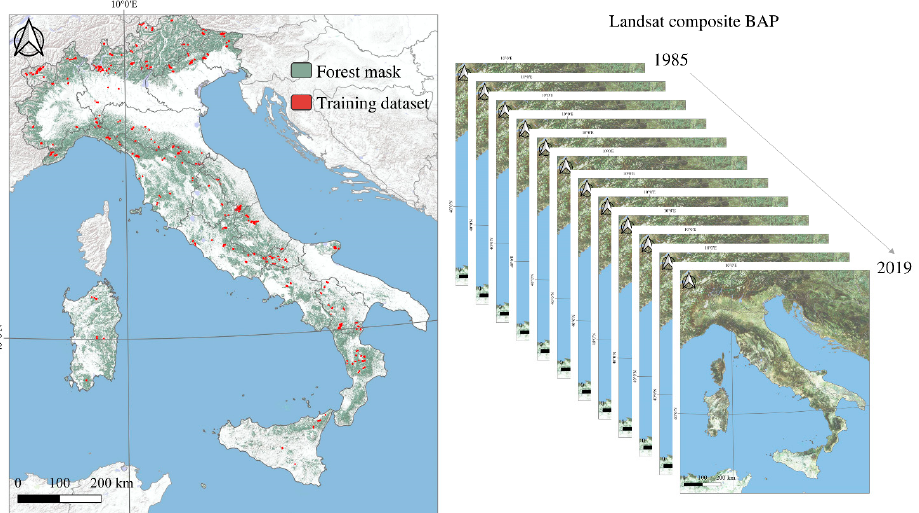
Figure 1. Study area (Section 2.1), forest mask (Section 2.1), BAP (Section 2.2), and training data (Section 2.3).